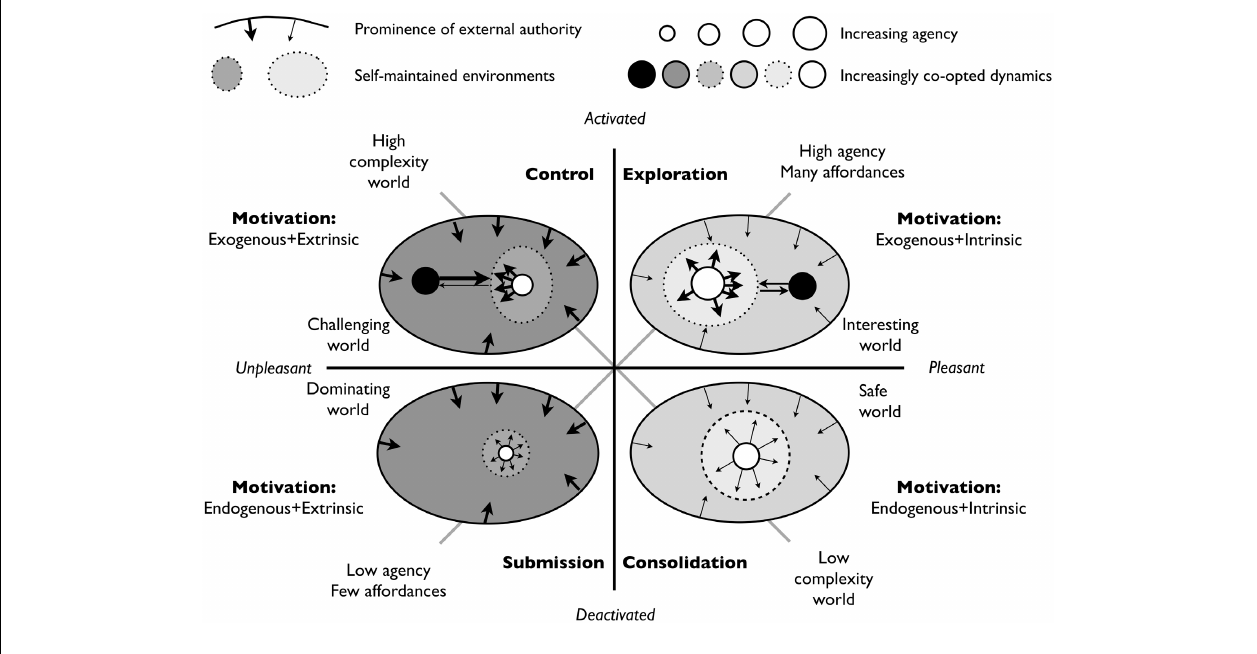
FIGURE 4 | Motivation, authority, and co-creation. This figure combines four qualitatively different types of environments in terms of the complexity of action selection and affordance content. The ovals around the agent (white circle) defines self-maintained